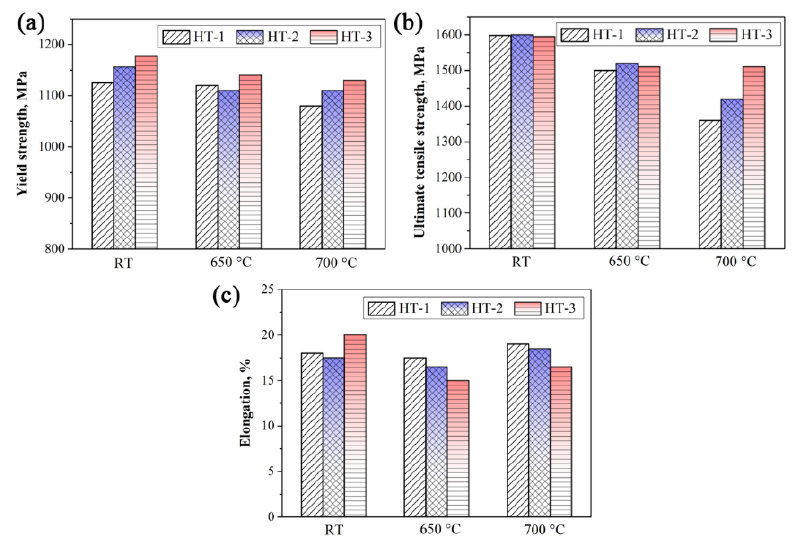
Figure 8. Tensile properties of the heat-treated P/M superalloy FGH4107: ( a ) yield strength; ( b ) ultimate tensile strength; ( c ) elongation.